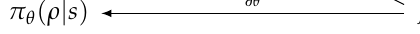
Figure 6. Branch diagram for the derivative of J